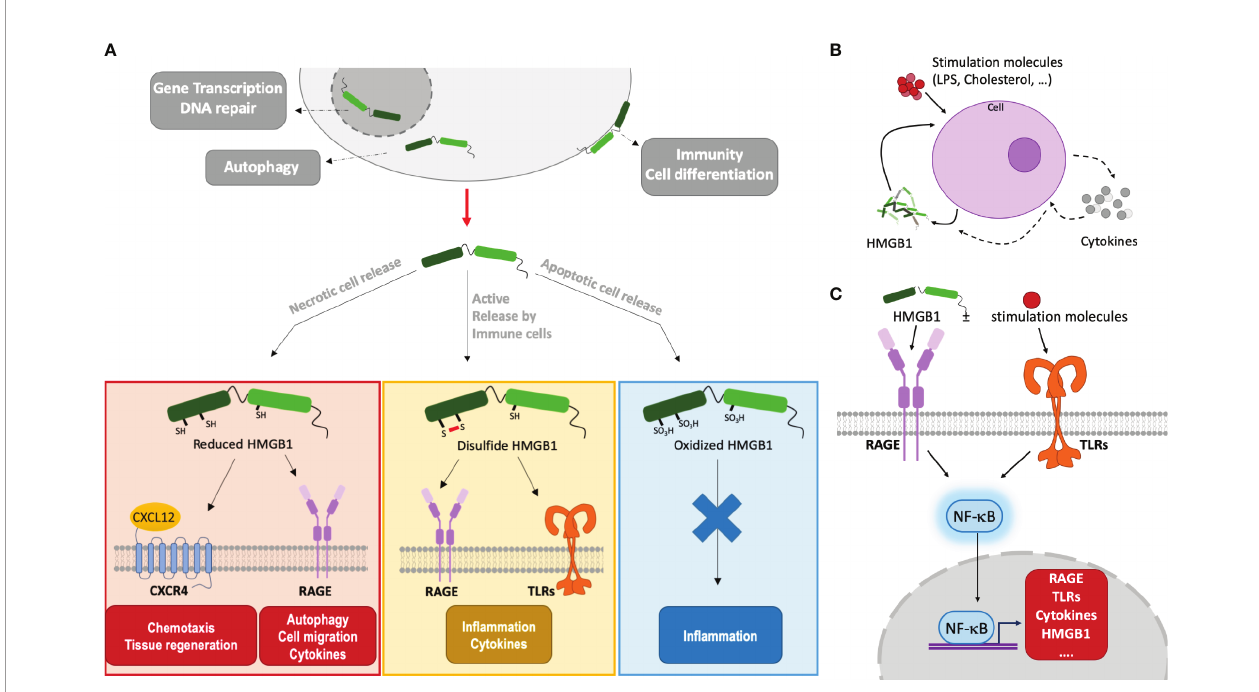
FIGURE 3 | HMGB1 functions depend on its localization/environment, oxidation state and its alarm signaling involves autocrine and paracrine ampli fi cation loops. (A) HMGB1 effects depend on its localization and oxidation state. Mainly located inside the nucleus, HMGB1 binds DNA and modulates nucleosome stability, thus regulating gene transcription. In the cytoplasm, it plays a role in autophagy. When actively or passively released outside cells, HMGB1 takes part in immunity, in fl ammation and cell differentiation. HMGB1 can stimulate immune cells (leukocytes, macrophages … ). The HMGB1 redox state evolves in relation to its context. Fully reduced, HMGB1 binds to CXCL12 to promote cell recruitment and migration by activation of CXCR4 at the cell membrane. Or, by binding RAGE, it is internalized and it can promote autophagy, cell migration and cytokines synthesis. Through RAGE and TLRs signalization, disul fi de HMGB1 induces in fl ammation and cytokines secretion. When fully oxidized, HMGB1 does not interact anymore with the receptors and may enhance immune tolerance. (B) HMGB1 amplifying feedback loop. Under different stimuli, a cell (macrophage, leukocyte, smooth muscle cell, … ) can produce and secrete HMGB1 and its receptors directly or via the production of cytokines. Once HMGB1 is produced and released, a positive feedback loop is created to enhance its production at the protein level by the initial cell or by neighboring cells, hereby amplifying its effects. This is associated to the secretion of cytokines and other in fl ammatory molecules. (C) NF- k B mediated ampli fi cation of HMGB1 and its receptors. By interacting with RAGE and TLR receptors, HMGB1, often in complex with stimulating molecules, will activate the NF- k B pathway. This will induce the transcription of HMGB1, its receptors, and cytokines, leading to an ampli fi cation of the in fl ammatory